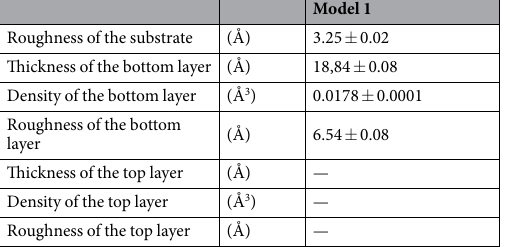
Table 1. Result of the fit of the XRR data using the stack model described in paper.